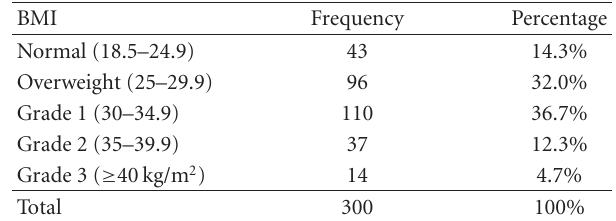
Table 1: Body mass index (BMI) in 300 Mexican